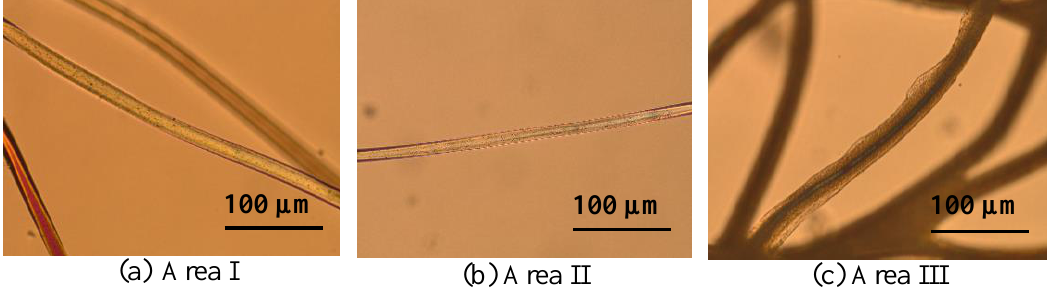
Figure 2. Pictures of the PA 6.6 fibres treated with solvents of the corresponding area: (a) No effect of the solvent on the fibres; (b) Dissolution of the fibre surface leading to fibre thinning (DISS); (c) Formation of a swollen shell (SW).